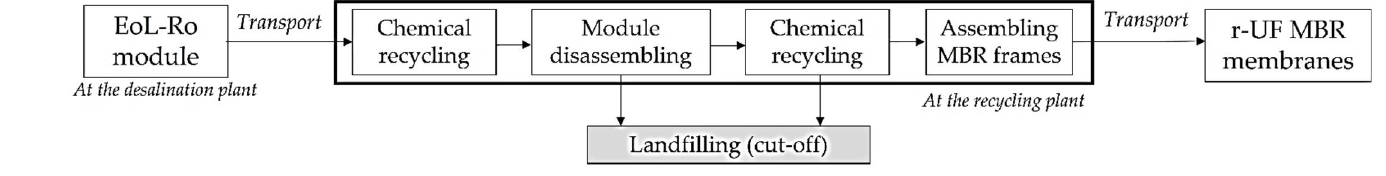
Figure 3. System boundaries of the economic analysis of r-UF membrane production process.